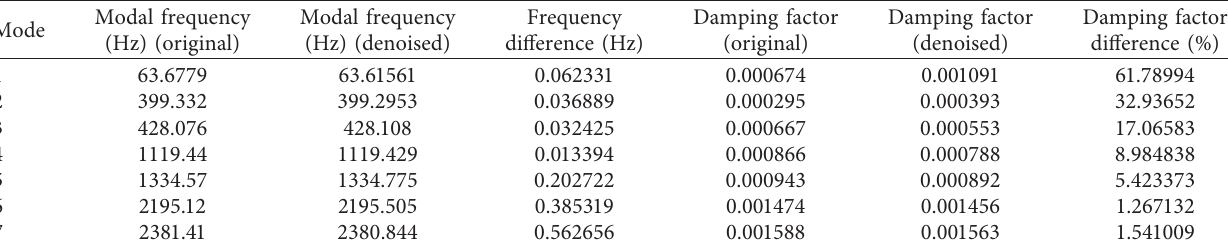
Figure 10: Curve fitting result of the noise-reduced FRF signal. (a) Curve fitted energy spectrum of denoised FRF. (b) Curve fitted phase spectrum of denoised FRF. Table 2: Modal parameters of the noised and noise-reduced FRF